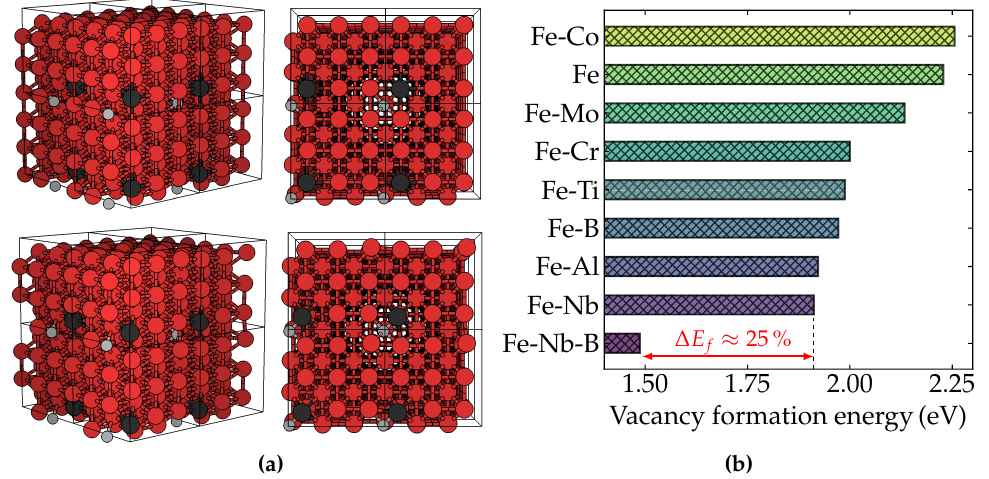
Figure 1. First-principles calculations of the Fe-Nb-B structural system. ( a ) Representation of the 3 3 3 supercell used in our calculations. Fe atoms are shown in red, B atoms in light gray, and × × other solutes in dark gray. The upper panel shows the supercell structures without vacancy, while the lower panel contains the supercell with a vacancy point defect. ( b ) The DFT-calculated vacancy formation energy of BCC-Fe with several solutes: Fe-Co (2.26 eV), Fe (2.23 eV), Fe-Mo (2.13 eV), Fe-Cr (2.00 eV), Fe-Ti (1.99 eV), Fe-B (1.97 eV), Fe-Al (1.92 eV), Fe-Nb (1.91 eV), Fe-Nb-B (1.49 eV). The percentege difference between the energy required to form a vacancy in Fe-Nb and Fe-Nb-B is almost 25%, as indicated by the red arrow in the